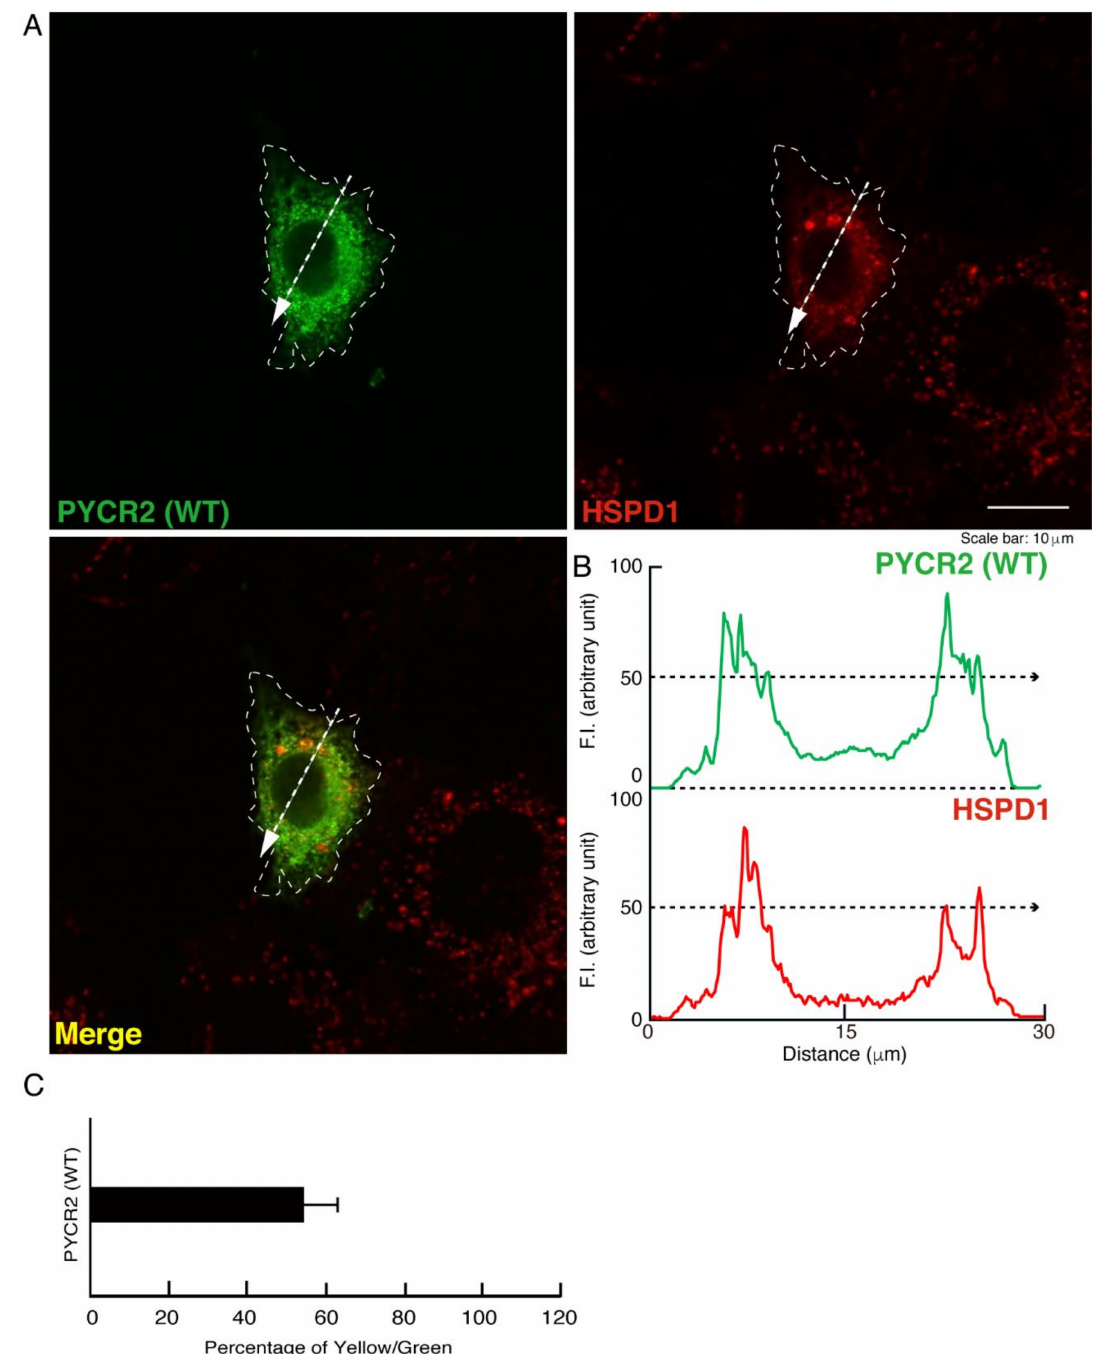
Figure 2. The wild type proteins are partially co-localized with the mitochondria. ( A , B ) COS-7 cells were transfected with the plasmid encoding the GFP-tagged wild type (WT) PYCR2 and stained with an antibody against the mitochondrion-specific antigen HSPD1 (red). GFP-tagged WT PYCR2 proteins were identified by their green fluorescence color. The approximate outline of the cell is surrounded by white dotted lines. Scan plots were performed along the white dotted lines in the direction of the arrows in the color images (green and red as well as merged images). Graphs showing the fluorescence intensities (F.I., arbitrary units) along the lines in the direction of the arrows were depicted in the right bottom panels. ( C ) Percentage of merged yellow fluorescence pixel values per green fluorescence ones are shown in the